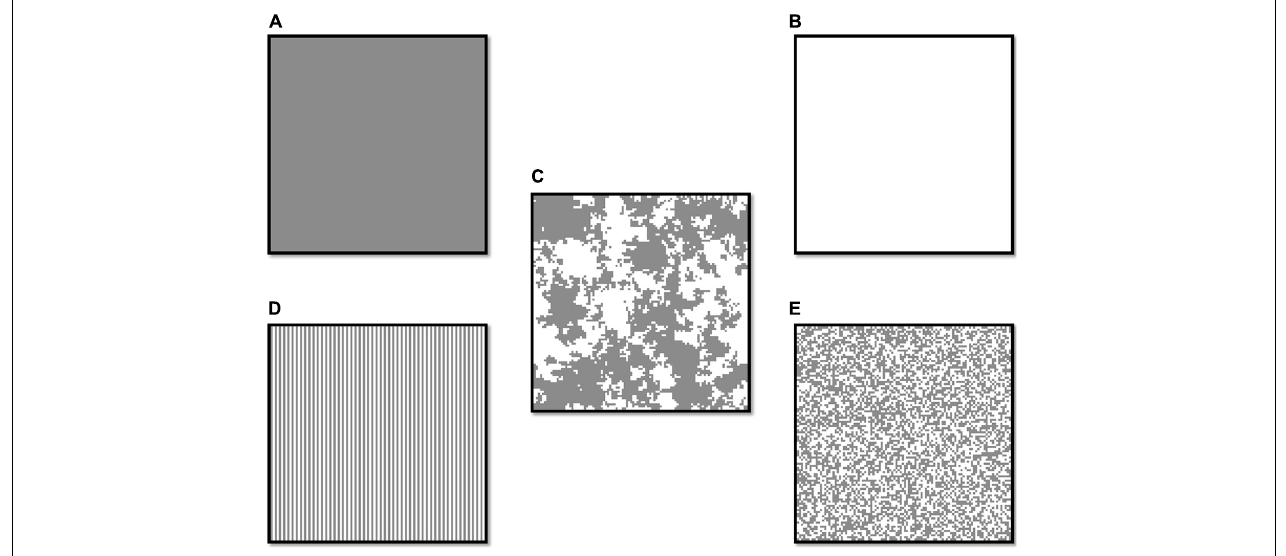
FIGURE 1 | Interface of the model used to simulate Agricultural landscapes (Al): (A) agriculture (crop dominated landscape); (B) Forest (tree dominated landscape); (C) clumped (separated areas of crop and tree dominated landscapes); (D) linear (lines of crop alternating with lines of trees); (E) Random (random distribution of crop patches and tree patches). Linear and Random Al represent modern (mostly mechanized) and traditional Agroforests,